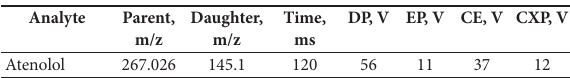
Table 4. Multiple reaction monitoring (MRM) parameters of atenolol.